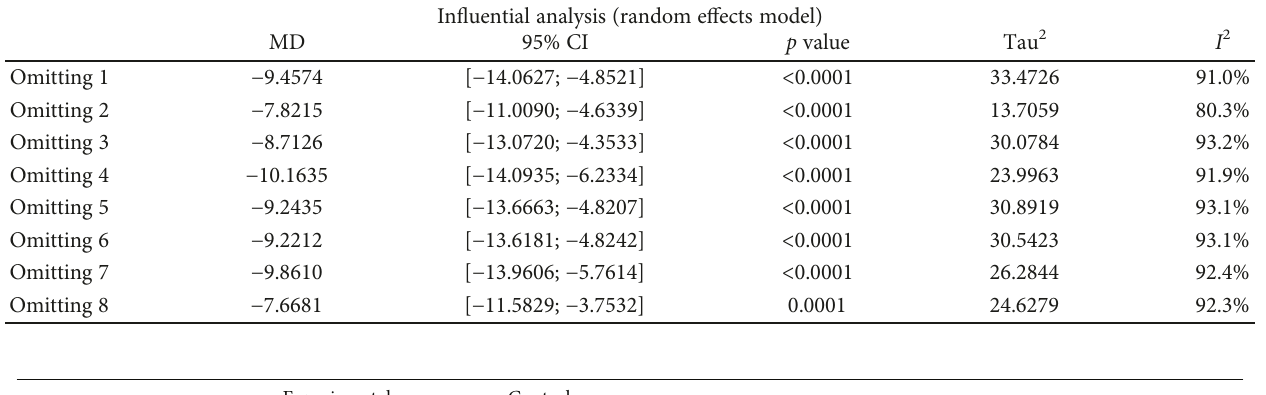
Figure 3: Forest plot of the changes of peripheral blood CD4+ T cell in human brucellosis patients compared with controls. Table 3: The results of CD4+ T cell data sensitivity analysis.